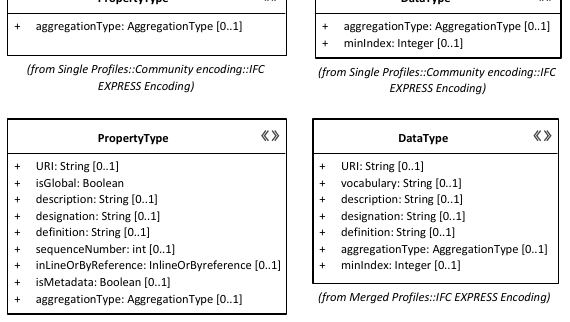
Figure 9. Stereotypes in the original and merged IFC EXPRESS Encoding Profile.